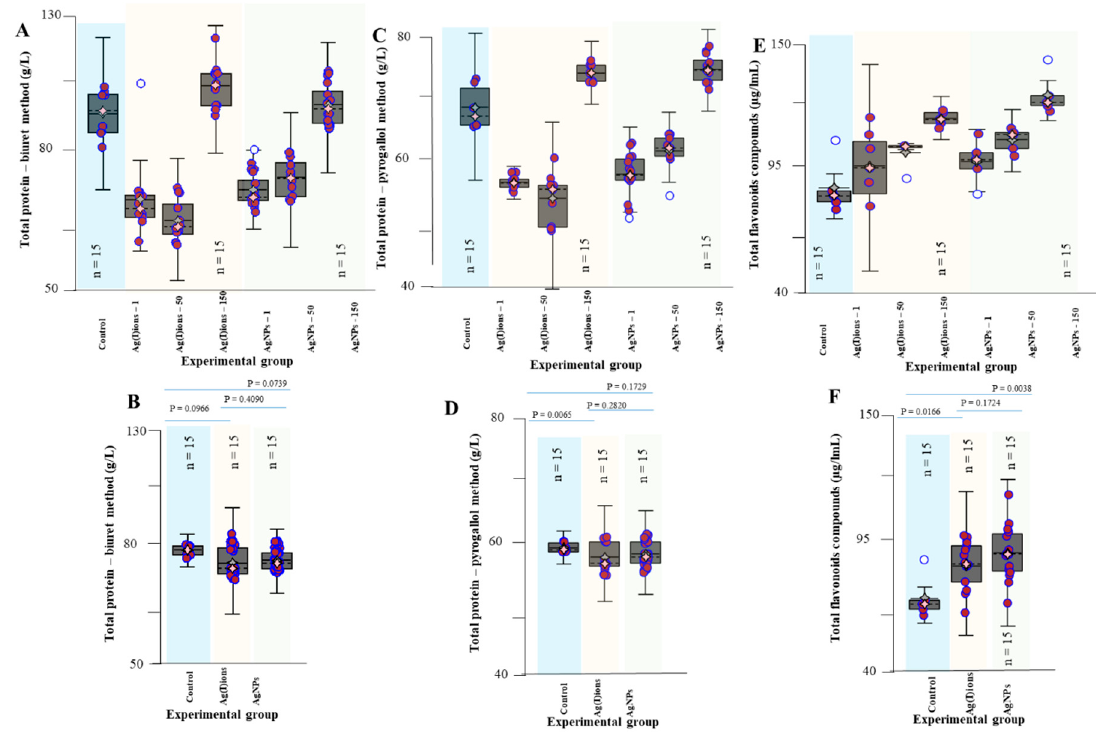
Figure 6. Chemical analysis of the primary roots of germinating maize plants after 96 h exposure to Ag(I) ions and AgNPs. In the study, the following parameters were analysed for all tested concentrations of Ag(I) ions and AgNPs. ( A ) Total protein concentration determined by the biuret method. ( B ) The average total protein ‒ biuret method. ( C ) Total protein concentration determined by the pyrogallol red-molybdate method. ( D ) The average total protein-pyrogallol red-molybdate method. ( E ) Total flavonoid concentration. ( F ) The average value of the total flavonoid concentration.